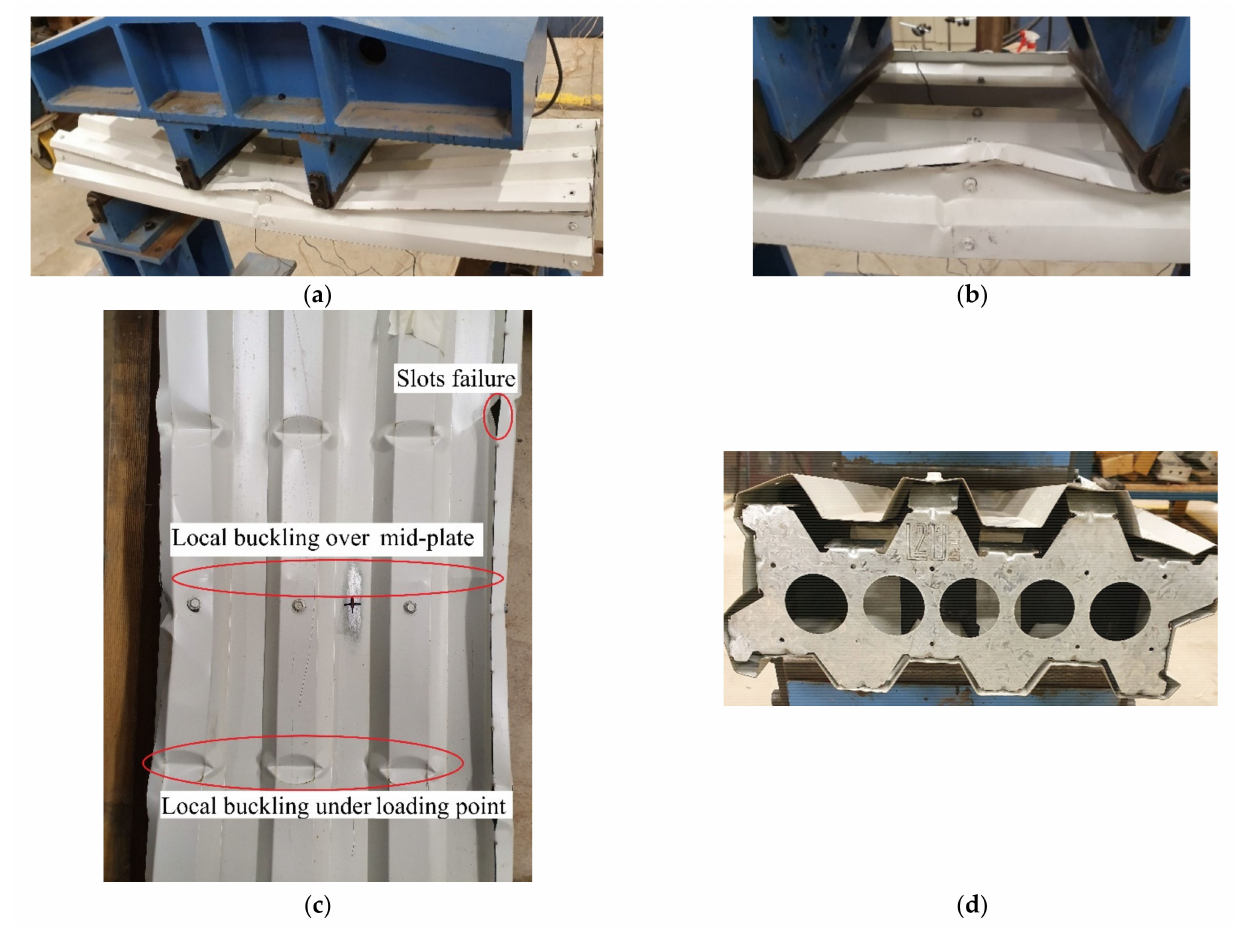
Figure 7. ( a ) Failed SC-P panel. ( b ) Buckling over mid-plate in SC-P. ( c ) Failure points on SC-P panel ( d ) Separation of panel skin from endplates. Panels without Mid-Plate The panel without the mid-plate also failed by flexure (Figure 8a). However, local buckling was noticed only below the load points. It is seen from Figure 8b that only the top skin of the panel suffered failure while the bottom skin remained significantly undamaged. Similar to panels with mid-plates, separation of the skins from the endplate was noticed at higher displacement beyond 50